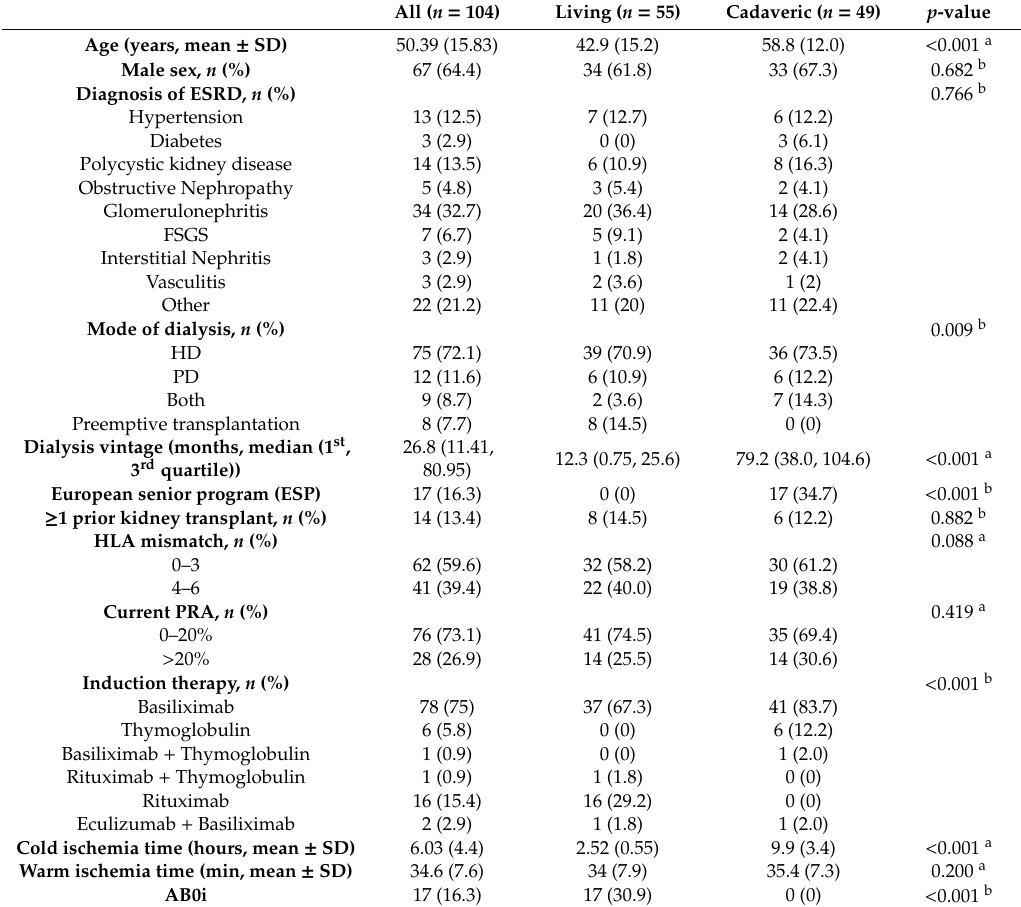
Table 1. Baseline characteristics of the transplant recipients.